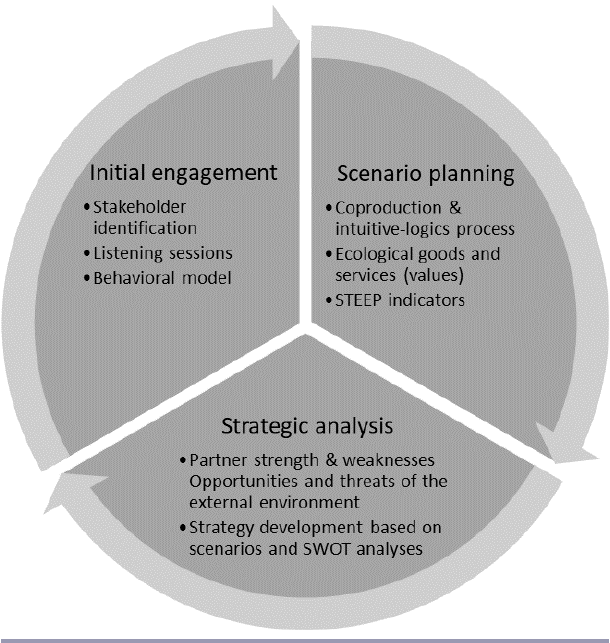
Fig. 2 . Possible stages of engagement for building adaptive capacity in social-ecological systems. Initial engagement with potential stakeholders involves listening sessions to